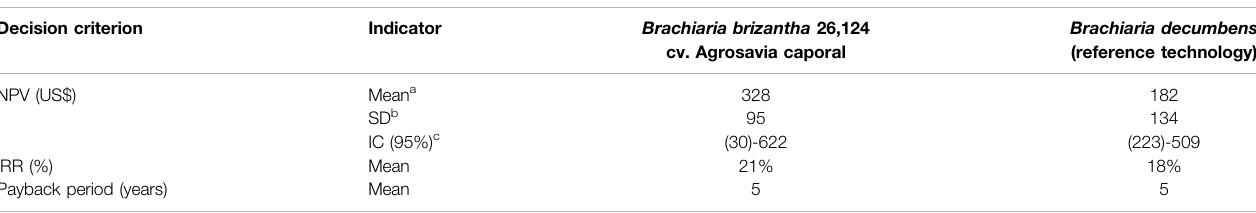
TABLE 6 | Pro fi tability indicators of the simulation